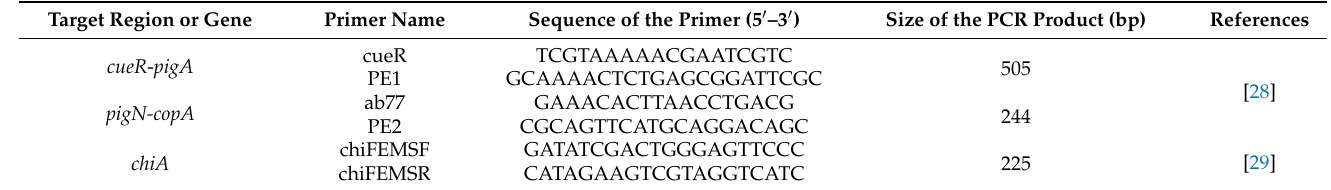
Table 1. Primer pairs used for PCR amplification of genes encoding for prodigiosin ( ceuR and copA ) and chitinase ( chiA ) of S. marcescens